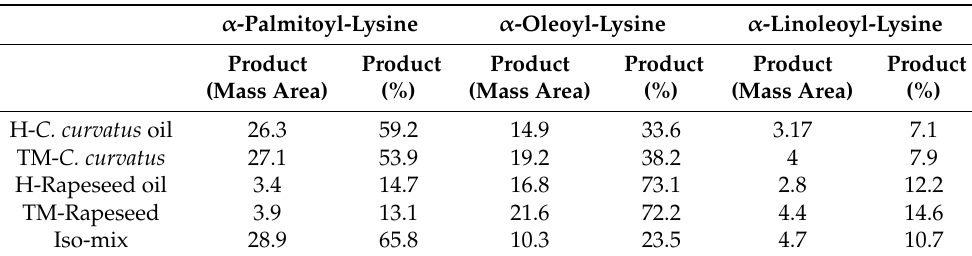
Table 9. Enzymatic acylation by aminoacylases, Product (Mass Area) referred to the N- α -acylation of lysine by an AD, Product (%), is the percentage of each product in the sum of 3 main products that occurred in each oil or FA mixture. HPLC-MS analysis provided Mass Area M + H + .